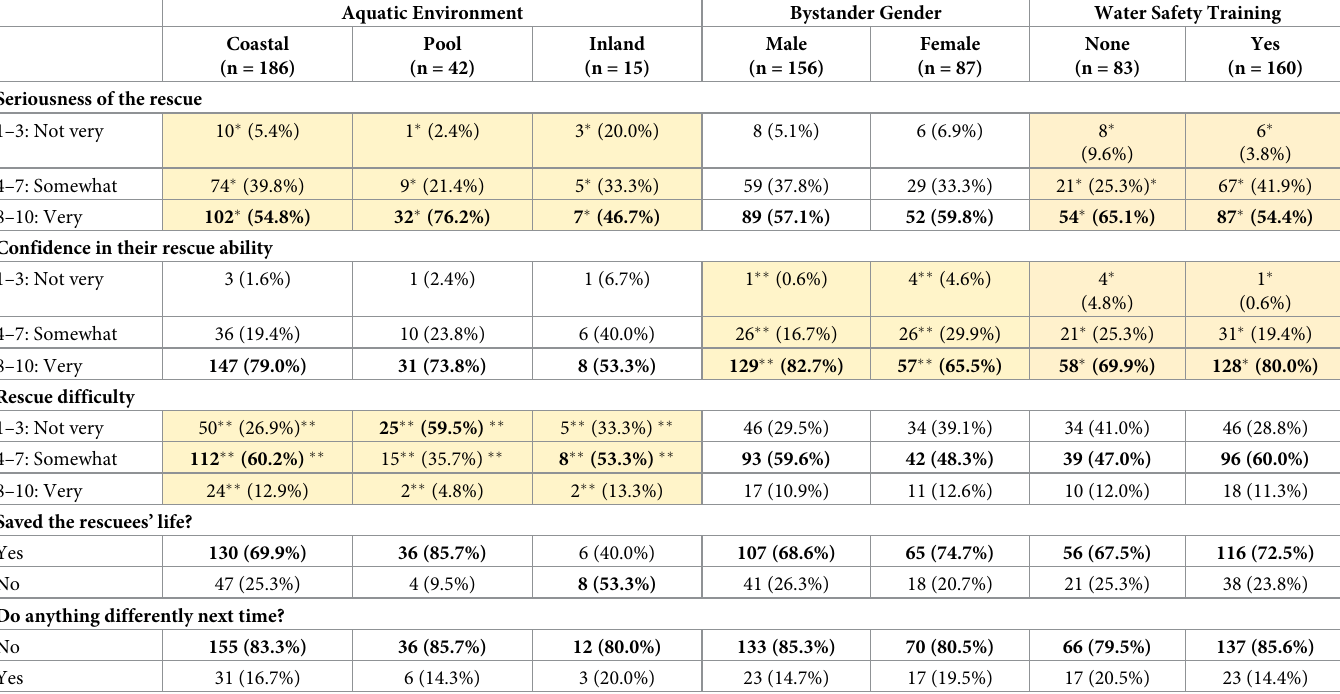
Table 5. Bystanders’ reflections on their most recent rescue. Percentages are indicated in parentheses with those in italics related to sample sizes shown in italics. Values in bold represent maximums for relevant categories. Shaded areas were found to be statistically significant. Asterisks represent the significance level of the relationship, where � = p � 0.05; �� = p � 0.01 and ��� = p �